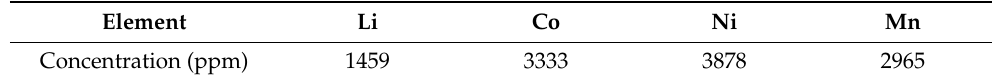
Table 2. The metal composition of